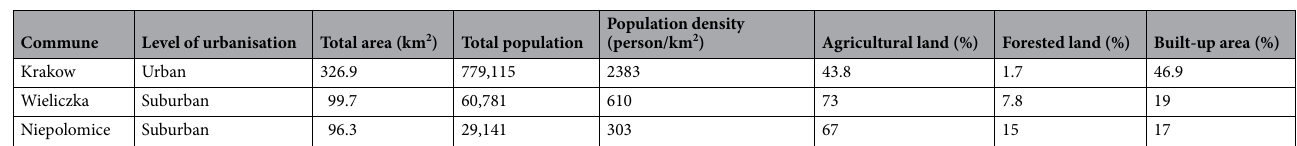
Table 2. Main descriptors of the study